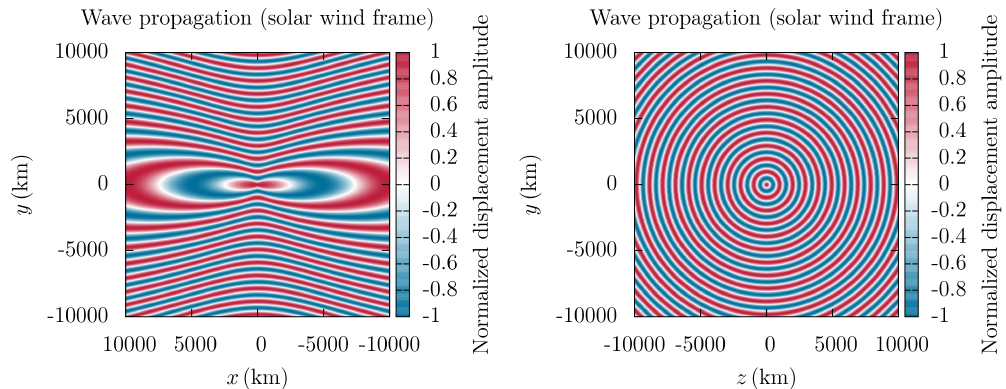
and | k | = k 0 = 6 . 4 × 10 − 3 km − 1 is shown in xy (left) c